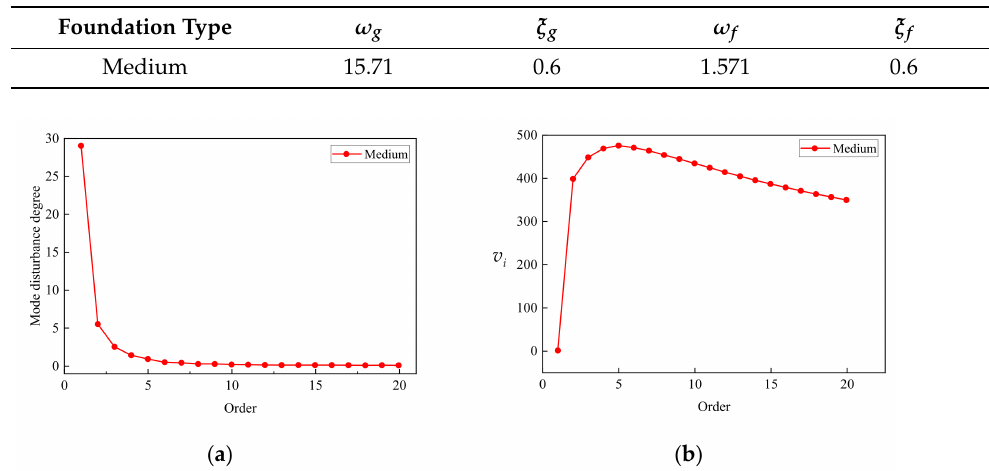
Table 2. Foundation frequency and damping ratio.